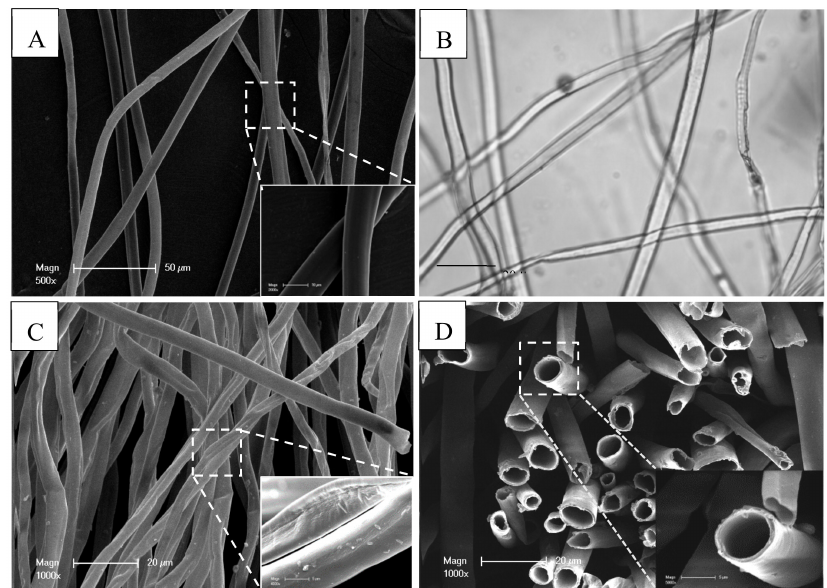
Figure 3. SEM and optical microscope images for poplar catkin fibers (( A ) and ( B ) longitudinal surface before dewaxing; ( C ) longitudinal surface after dewaxing; ( D ) cross-section after dewaxing; the insets in C and D are large magnification images).